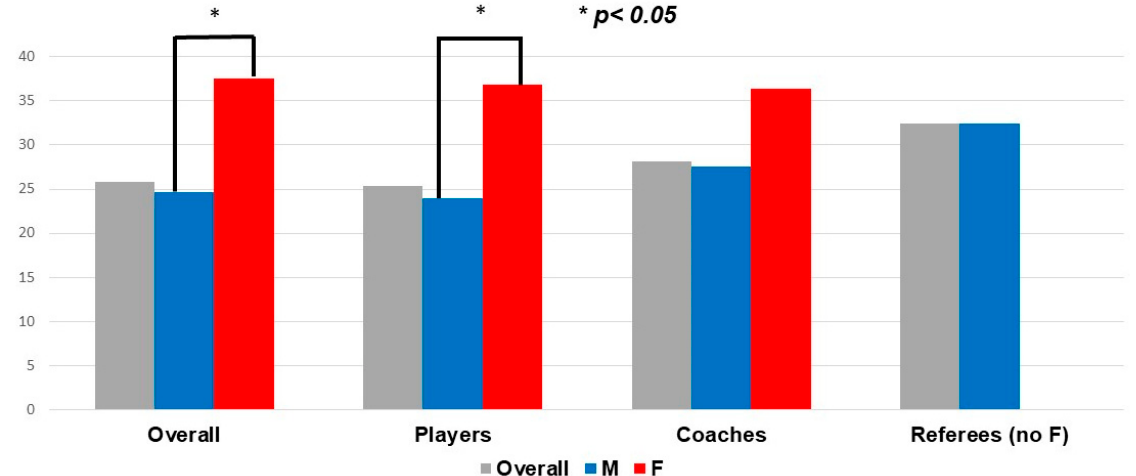
Figure 3. Rate of smokers in the whole study population and according to age group and gender. M: male; F: female. * p < 0.05. Grey = overall population; red = female; blue = male. Table 2. Characteristics of smokers (upper part) and vapers (lower part) in the whole population and according to the